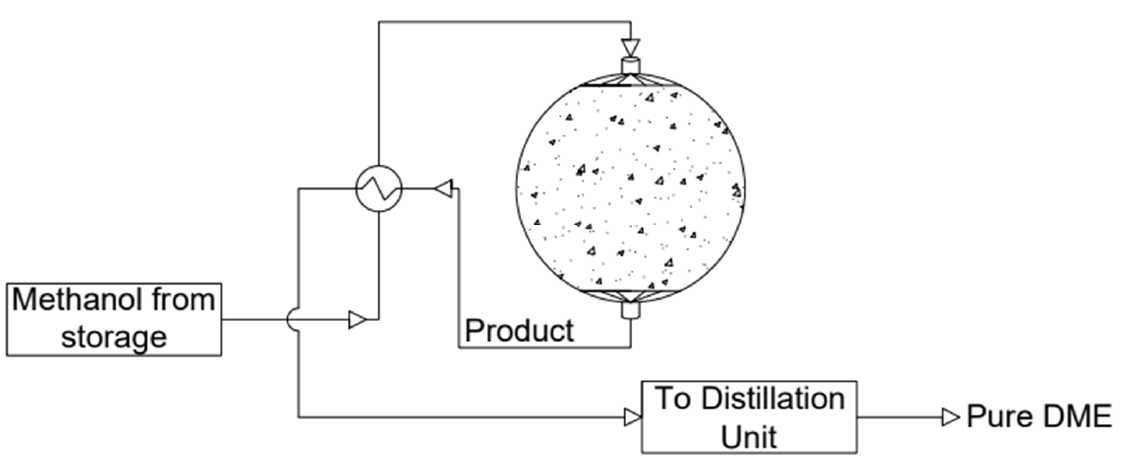
Figure 17. Scheme of a reactor with a spherical membrane. Developed based on [93].